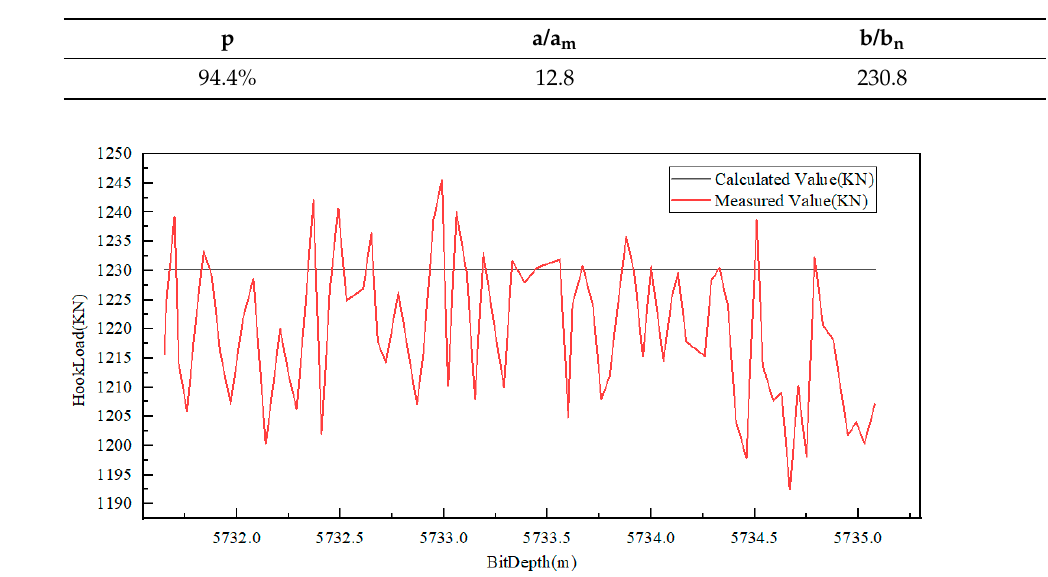
Figure 4. Distribution of measured and calculated POOH hookload before stuck pipe.